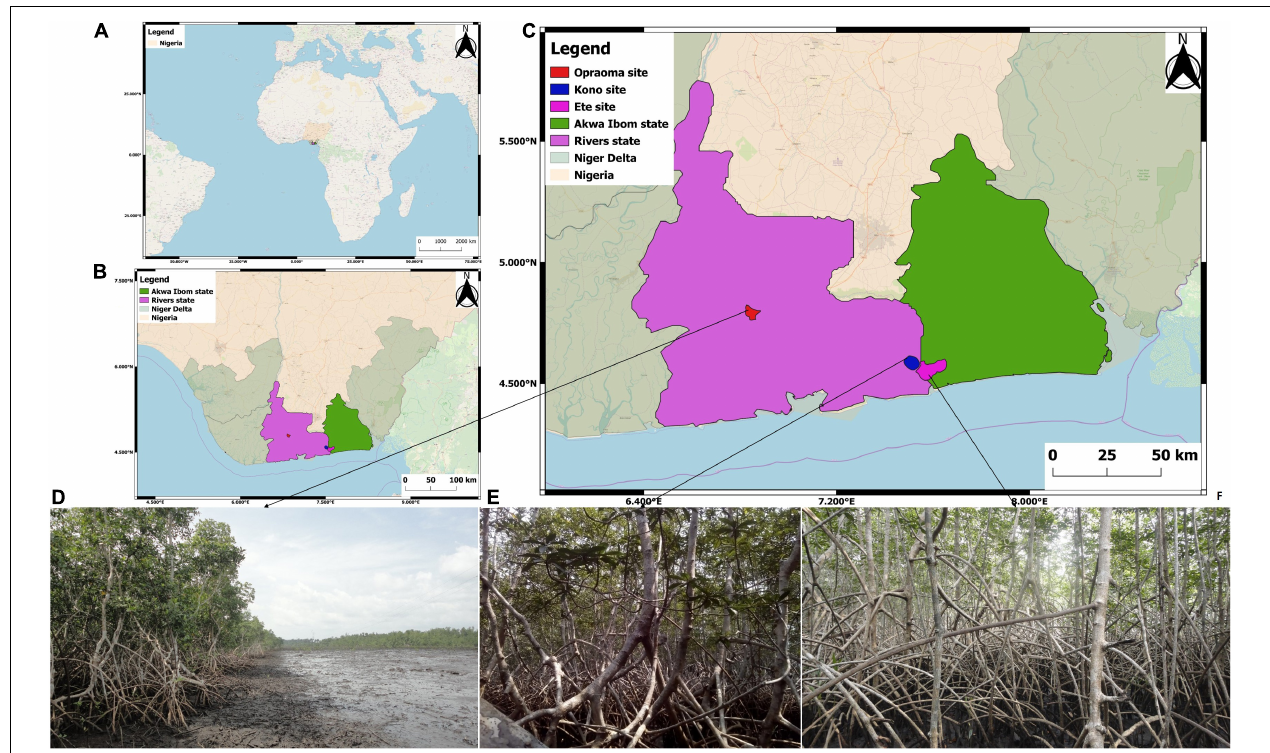
FIGURE 1 | Location of the Nigeria in West Africa (A) , the Niger Delta states (B) , and field sites location (C) . Oproama (D) , Kono (E) , and Ete (F)